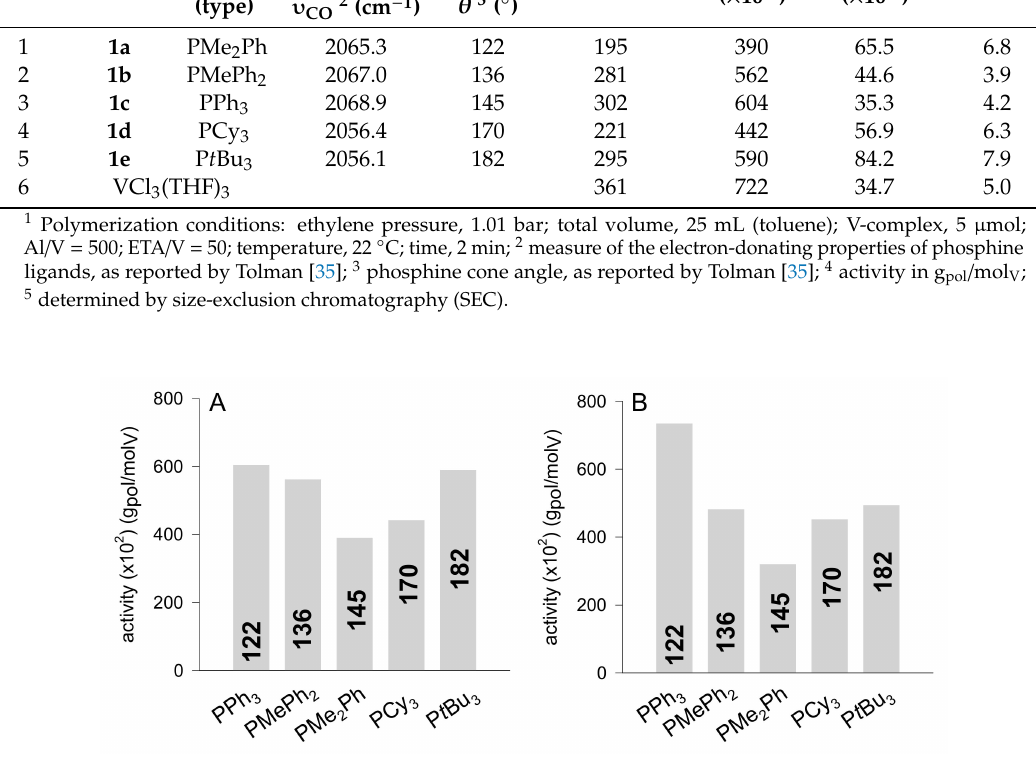
Figure 1. Plot of activity, calculated as g pol / mol V vs. the vanadium complexes employed [PPh 3 ( 1c